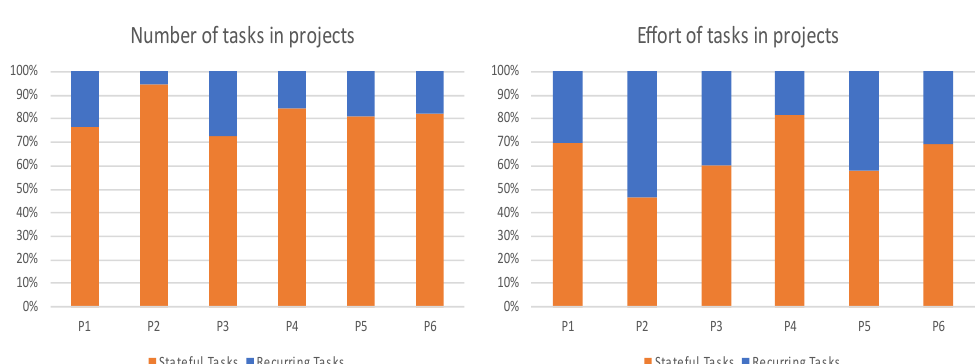
Figure 5. Updated numbers and effort of stateful and recurring tasks.